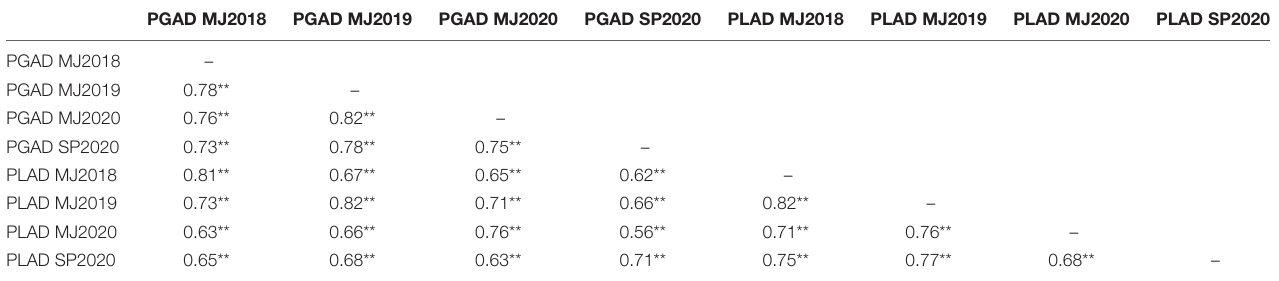
TABLE 5 | Pearson’s correlation coefficient between four trials at Manjimup (MJ) and South Perth (SP) Western Australia in 2018–2020 of 232 wheat lines for percent glume and leaf area diseased (PGAD and PLAD, respectively). PGAD MJ2018 PGAD